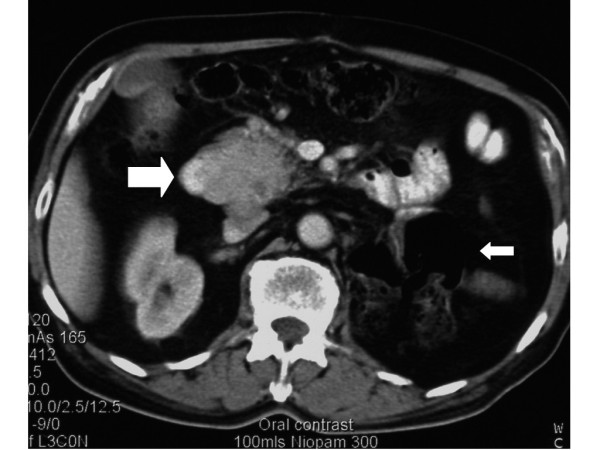
Abdominal CT scan. CT scan demonstrating the presence of a mass in the area of the pancreatic head and protruding into the duodenum (thick arrow) – note the previous left nephrectomy (thin arrow).